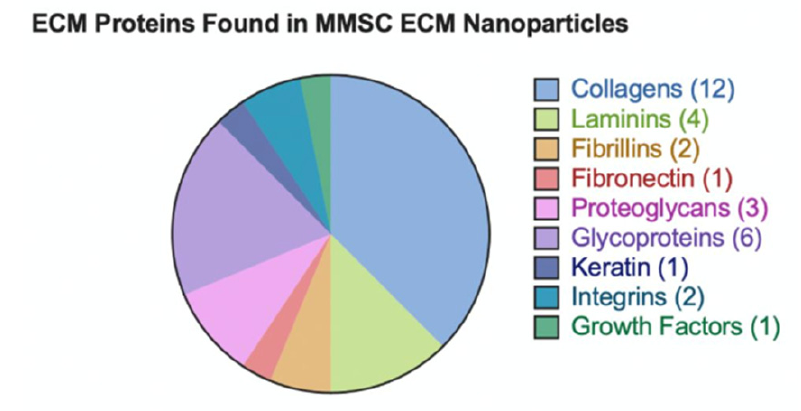
Figure 2. Comparison of the location of ECM proteins from the MMSC ECM nanoparticles.